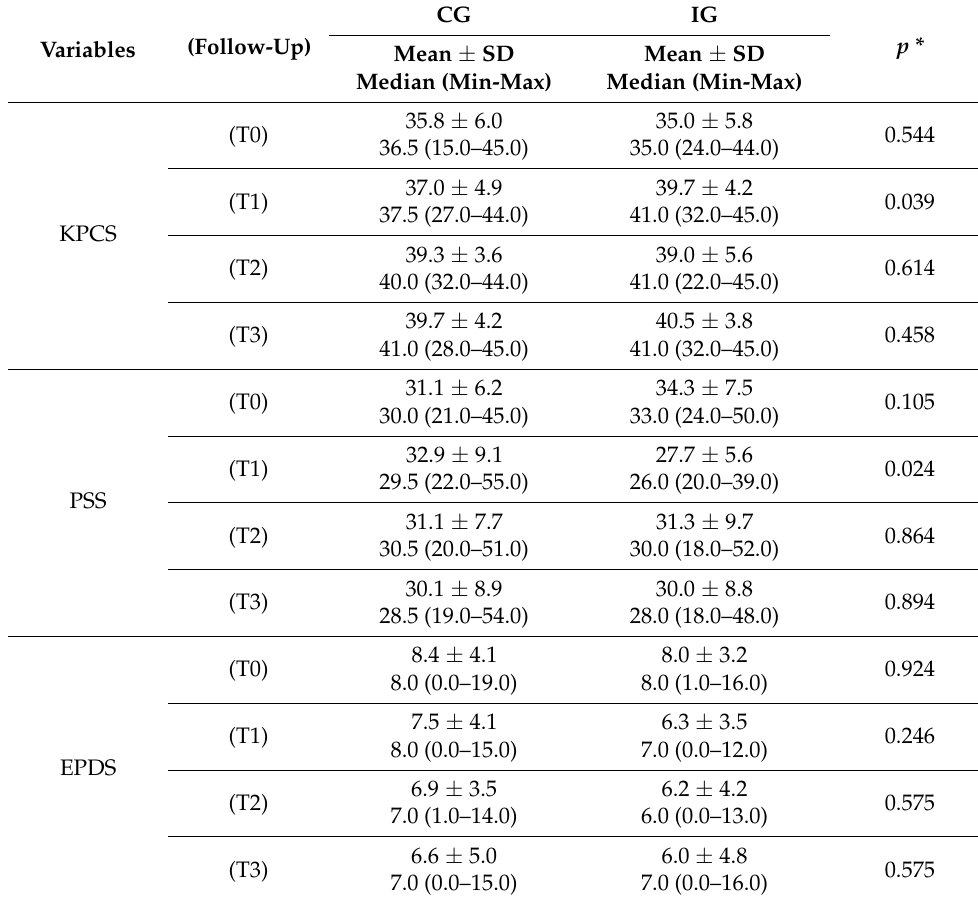
Table 2. Univariate analysis for the comparison of the KPCS, PSS and EPDS scores between the groups (CG and IG) in the different times of the